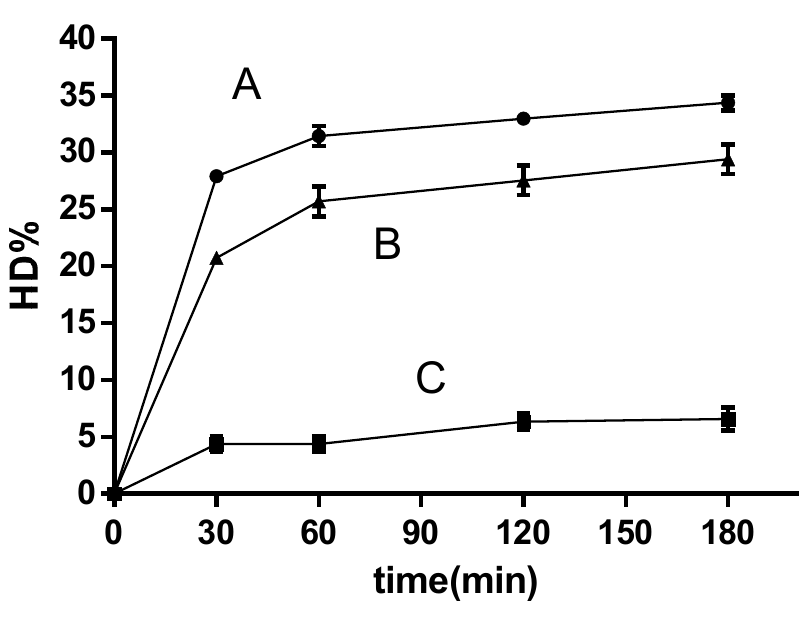
Figure 4. Hydrolysis degree progression of quinoa protein concentrate in aqueous suspension (10 mg/mL) using different enzymes (substrate enzyme ratio 1:10). Data are expressed as percentage (mean ± SD) of peptide bonds cleaved at defined time (min).